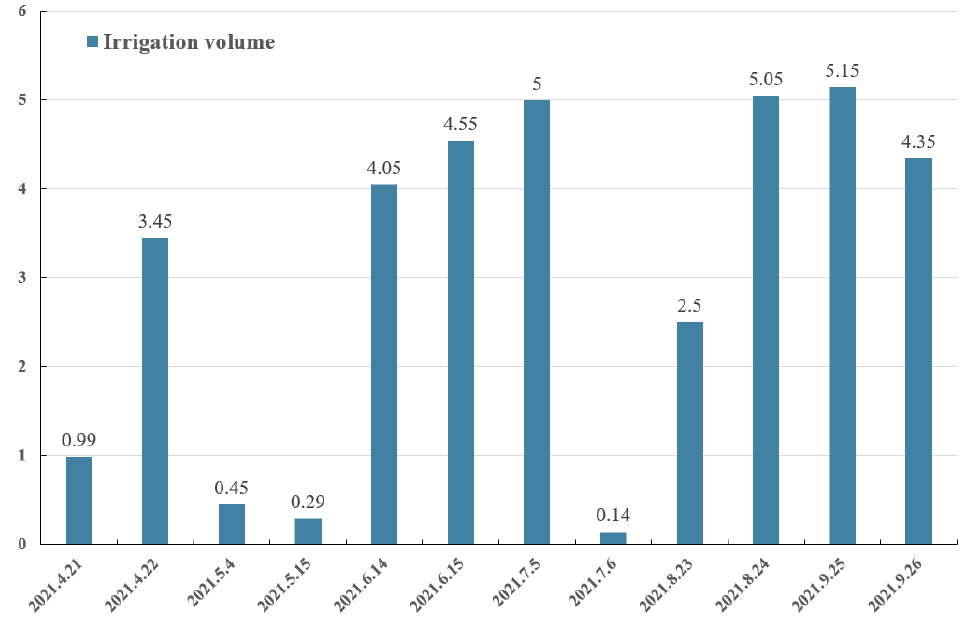
Figure 13. Graph of partial irrigation volume results.